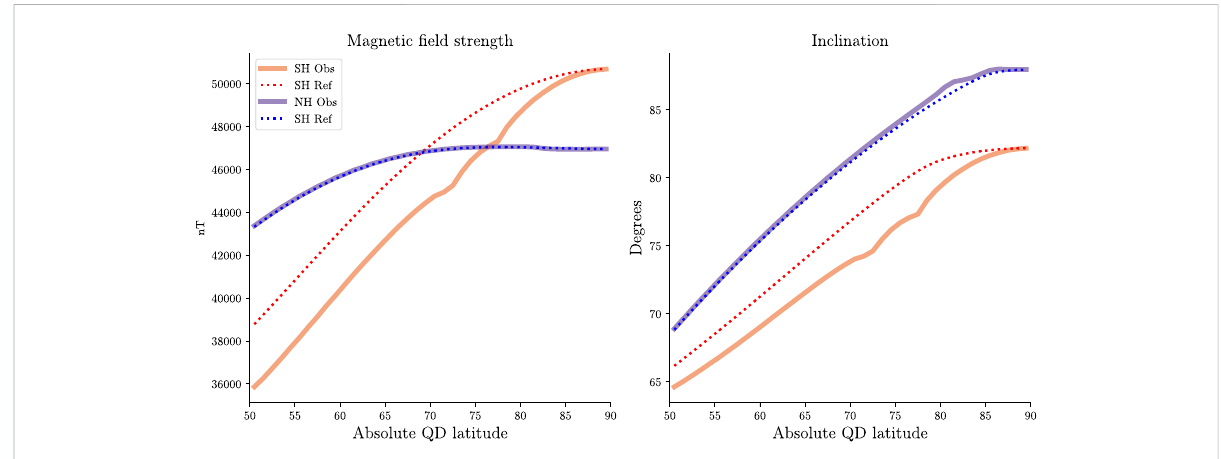
FIGURE 12 Marginal distributions of geomagnetic fi eld strength (left) and fi eld inclination (right) in the Northern (blue) and Southern (red) Hemisphere for the sampling distribution used to create the AMPS model (solid lines, denoted ” Obs ” ) and for a reference uniform distribution (dotted lines, denoted ” Ref ” ). Solid lines are obtained by weighting the fi eld strength and inclination in each hemisphere with the corresponding sampling distribution and integrating over longitude, while dotted lines are obtained by instead weighting with a uniform